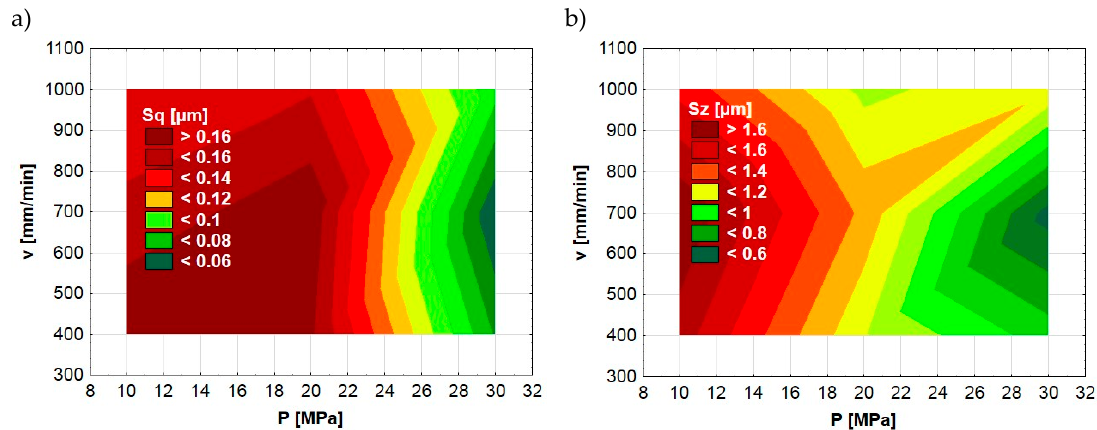
Figure 4. Dependence between ball-burnishing parameters ( P, v ) and surface topography parameters Sq ( a ), Sz ( b ).